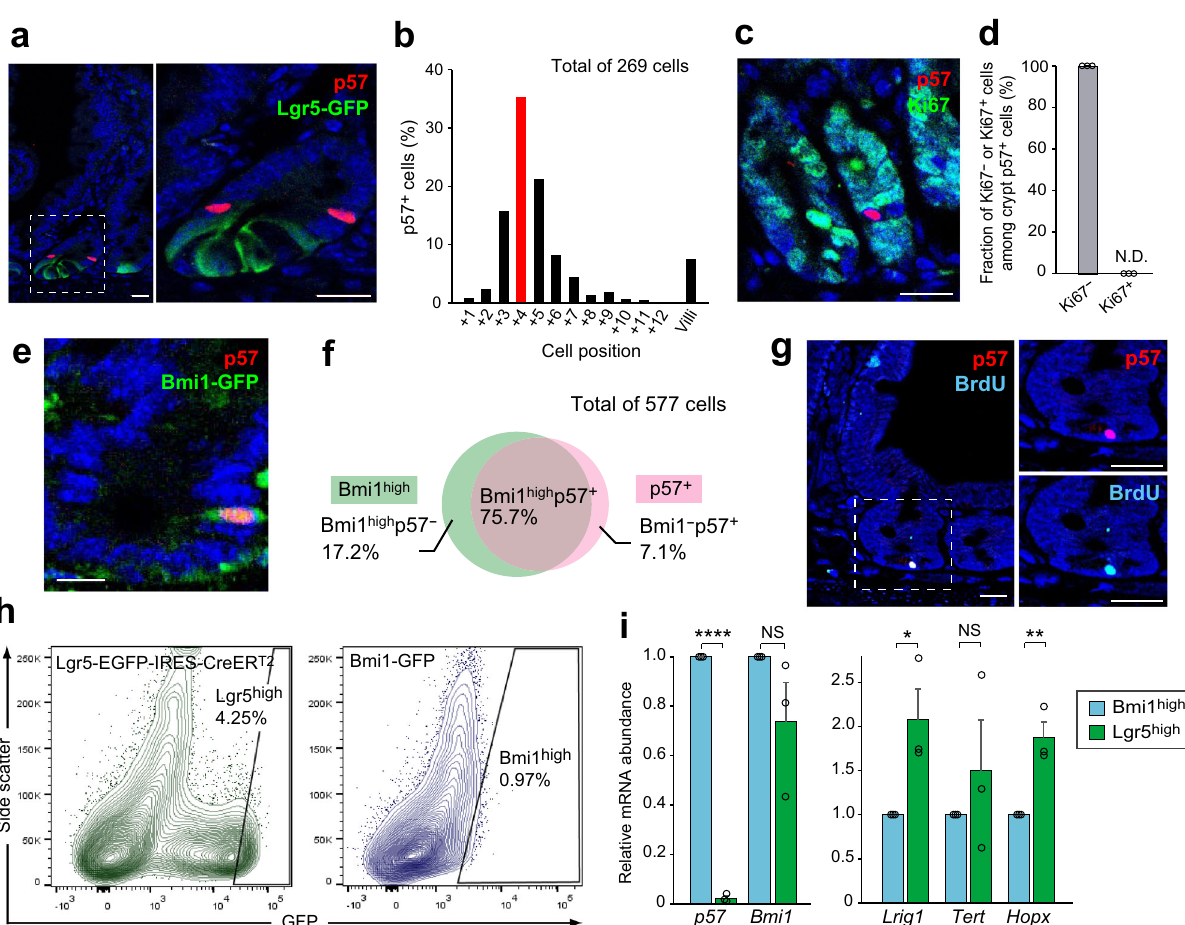
Fig. 1 p57 is speci fi cally expressed in quiescent cells around the + 4 position of intestinal crypts. a Representative immuno fl uorescence staining of p57 and Lgr5-GFP in the intestine of an Lgr5-EGFP-IRES-CreER T2 knock-in mouse. The boxed region in the left panel is shown at higher magni fi cation in the right panel. Arrowheads indicate p57 + cells. b Quanti fi cation of the number of p57 + cells at each position of crypts. c Representative immuno fl uorescence staining of p57 and Ki67 in the intestine of a wild-type (WT) mouse. The arrowhead indicates a p57 + cell. d Quanti fi cation of the fraction of Ki67 + or Ki67 − cells among p57 + cells. A total of 157 p57 + crypt cells was counted from three mice. N.D., not detected. e Representative immuno fl uorescence staining of p57 and Bmi1-GFP in the intestine of a Bmi1-GFP knock-in mouse. The arrowhead indicates a p57 + Bmi1 high cell. f Venn diagram showing the frequency of Bmi1 high p57 − , Bmi1 − p57 + , and Bmi1 high p57 + cells in the duodenum and jejunum. g Representative immuno fl uorescence staining of p57 and bromodeoxyuridine (BrdU) in the intestine of a WT mouse subjected to a 10-day BrdU label-retention assay. The boxed region containing a p57 + BrdU + cell (arrowhead) in the left panel is shown at higher magni fi cation in the right panels. h FACS gating strategy for sorting and analysis of Lgr5 high CBCs (left) and Bmi1 high cells (right) from the intestinal epithelium. i RT-qPCR analysis of relative mRNA abundance for p57 and putative + 4 position markers in Bmi1 high cells and Lgr5 high CBCs isolated as in h ( n = 3 mice). Quantitative data in d and i are means + SEM. NS (not signi fi cant), * P < 0.05, ** P < 0.01, **** P < 0.001 (two-tailed Student ’ s t test). Scale bars: 20 μ m ( a , c , g ) or 10 μ m ( l ). Source data are provided as a Source Data fi